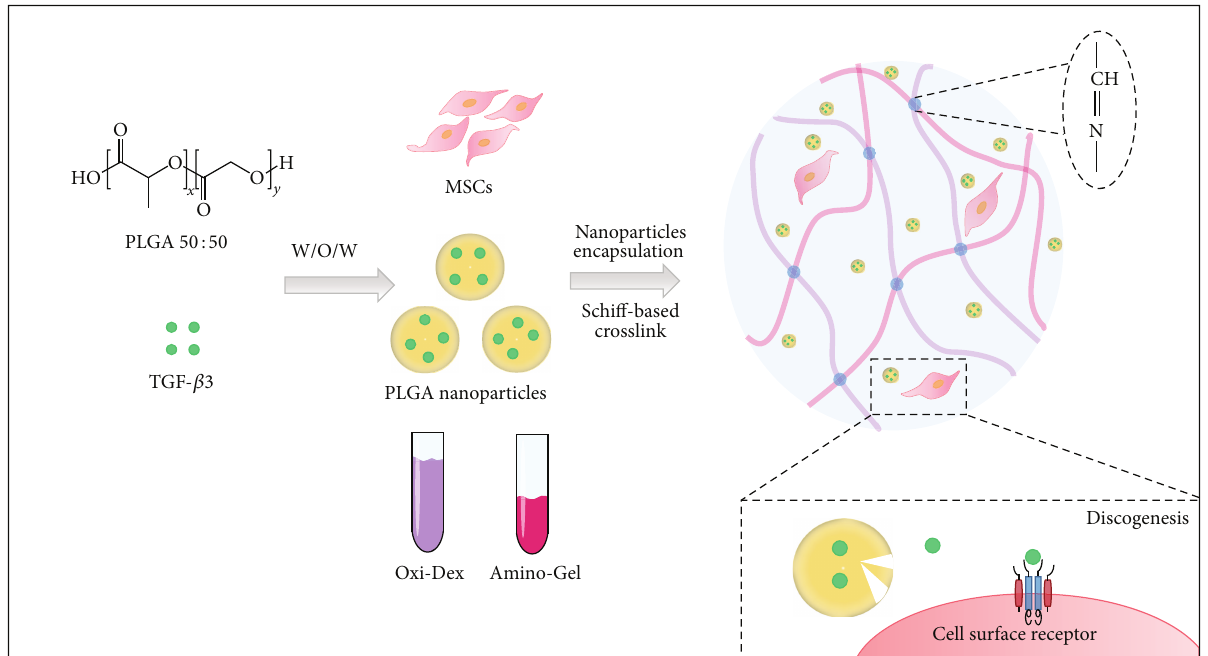
Figure 1: Schematic diagram of establishing the codelivery system of MSCs encapsulated in the dextran/gelatin hydrogel with the TGF- 𝛽 3- loaded nanoparticles. After the TGF- 𝛽 3-loaded PLGANPs were prepared using the W/O/W method, the MSCs and the TGF- 𝛽 3-loaded PLGANPs were incubated with the Oxi-Dex and amino-Gel solution. The codelivery system was formed by the Schiff-based reaction between the Oxi-Dex and amino-Gel. The TGF- 𝛽 3 could be released gradually with degradation of the PLGANPs for long-term discogenesis